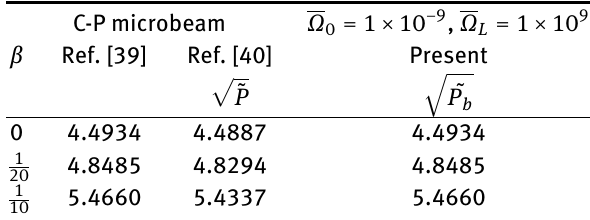
Table 2: Validation study for a clamped- pinned microbar using strain gradient elasticity theory.